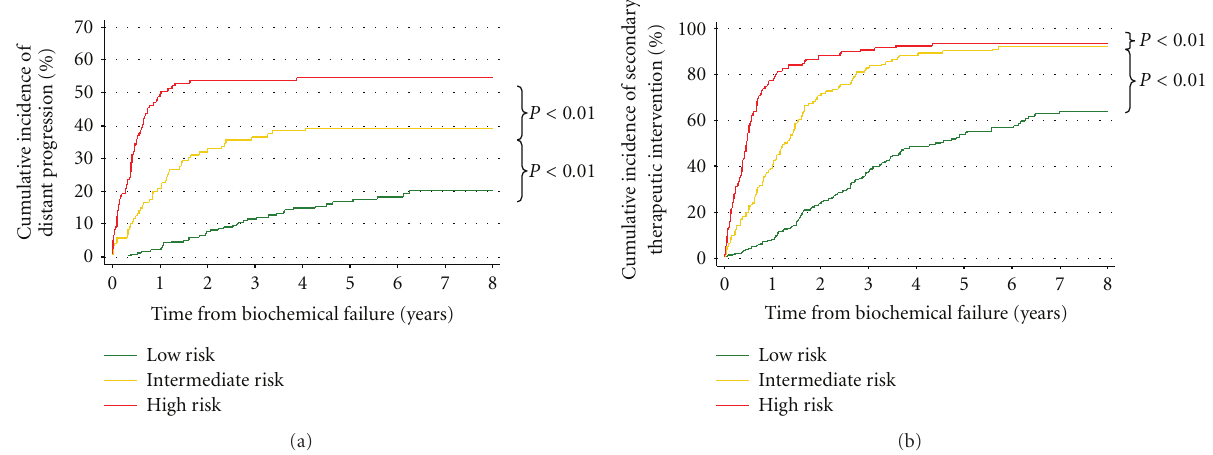
Figure 1: Outcomes after biochemical failure for the most predictive post-treatment failure category (BFRC) stratification scheme. (a) Cumulative incidence of distant progression. (b) Cumulative incidence of secondary therapeutic intervention.